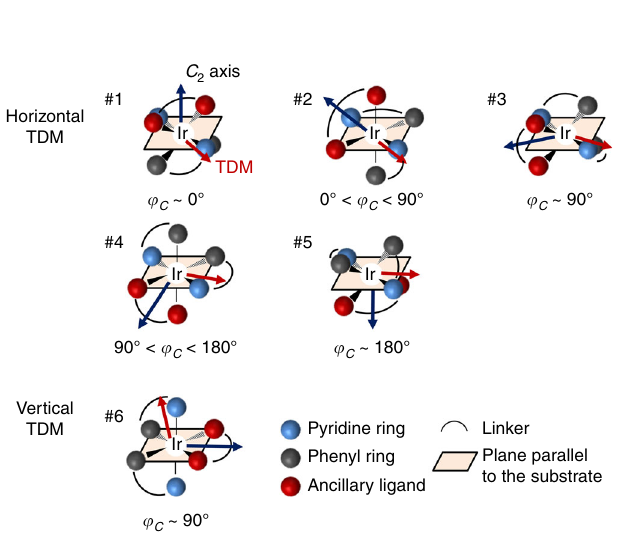
Fig. 4 Molecular con fi gurations of heteroleptic Ir complexes. The molecular con fi gurations of heteroleptic Ir complexes having horizontal and vertical transition dipole moments are schematically illustrated with blue , gray , and red spheres at the octahedral sites representing pyridine rings, phenyl rings, and the ancillary ligand ( – tmd), respectively. Dark blue and red arrows indicate the molecular C 2 axis and the TDM vector, respectively. Five con fi gurations of the molecule for horizontal TDM and one con fi guration for vertical TDM are illustrated depending on the angle of the C 2 axis